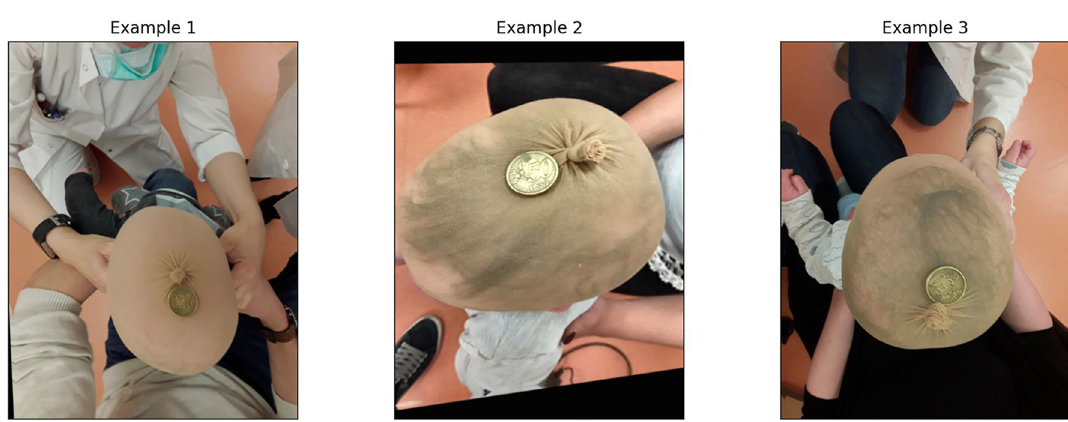
Figure 1. Example of different image augmentation on a randomly drawn image from the training